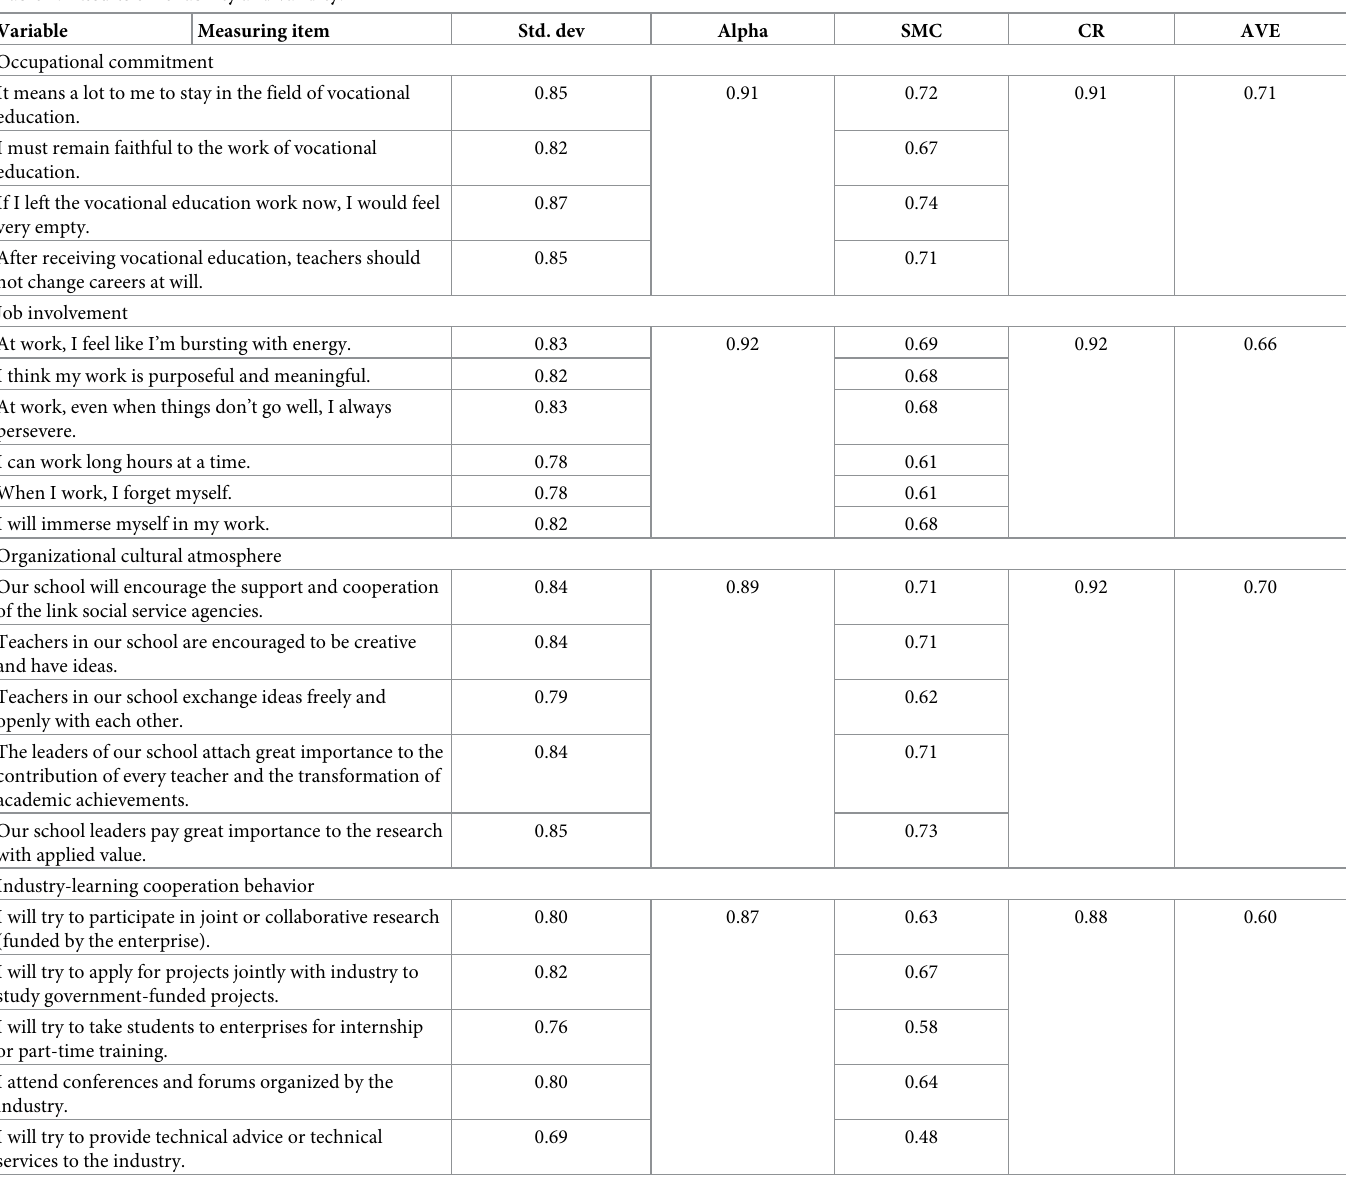
Table 2. Results of reliability and validity.